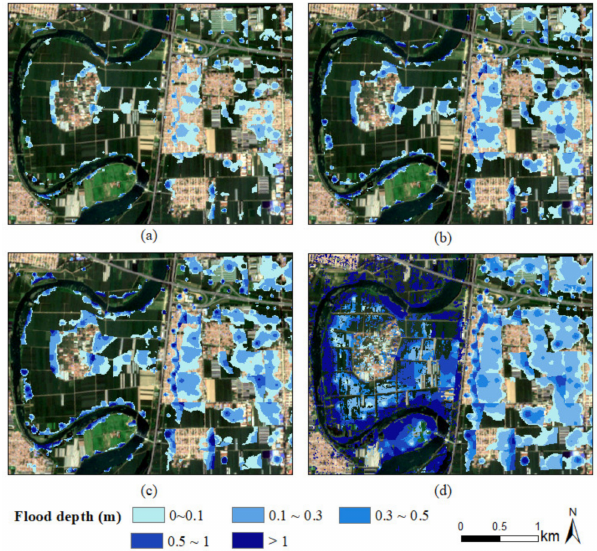
Figure 9. Flood depth simulation results: ( a ) 18 November 2020; ( b ) 16 May 2018; ( c ) 15 July 2018; ( d ) 20 August